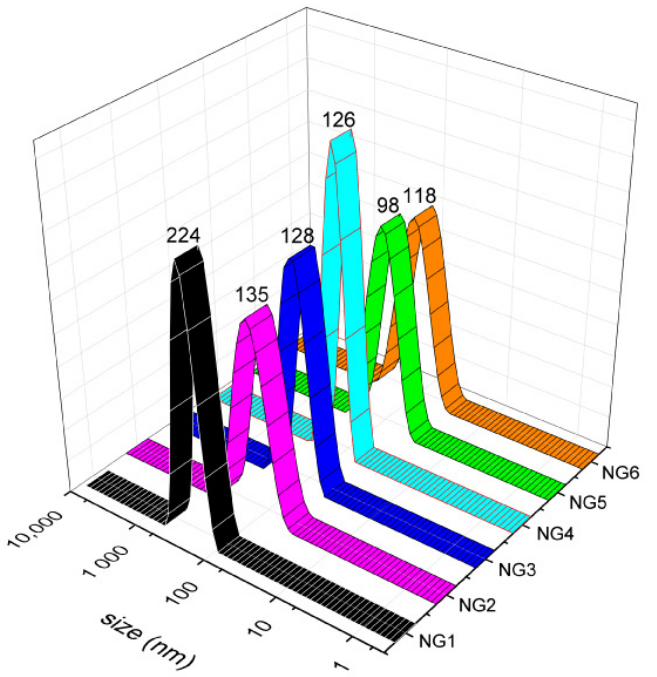
Figure 1. Size distribution by intensity of PNVCL-based nanogels containing VP or GAL.